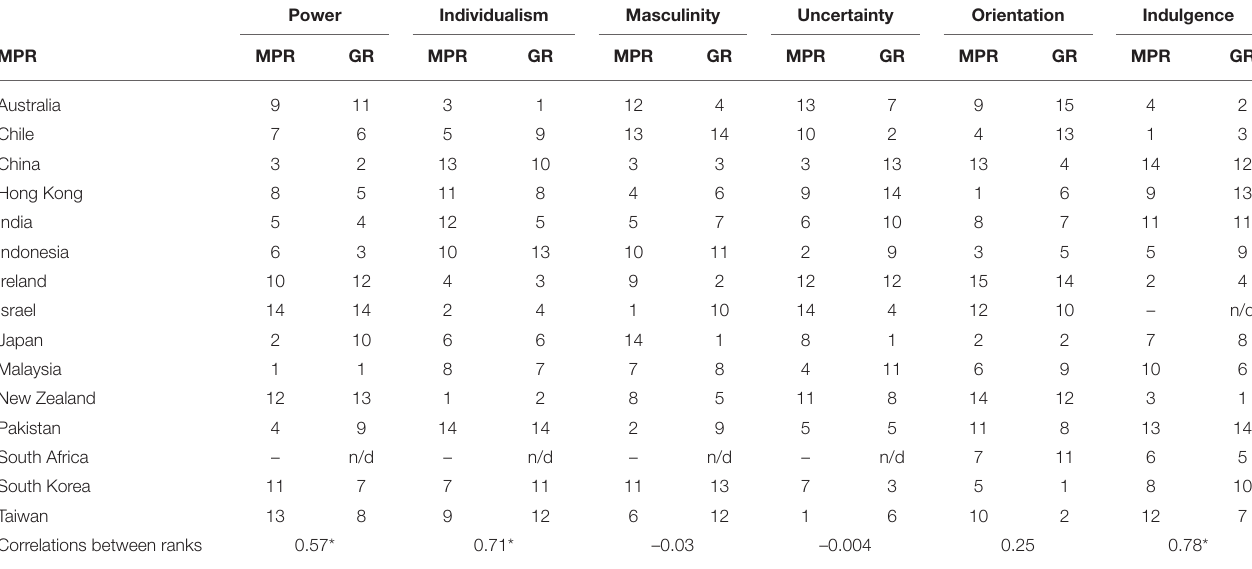
TABLE 3 | Adjusted ranking of country by dimension for medical participants’ data (MPR) compared with Hofstede’s general ranking (GR). Power Individualism Masculinity Uncertainty Orientation Indulgence